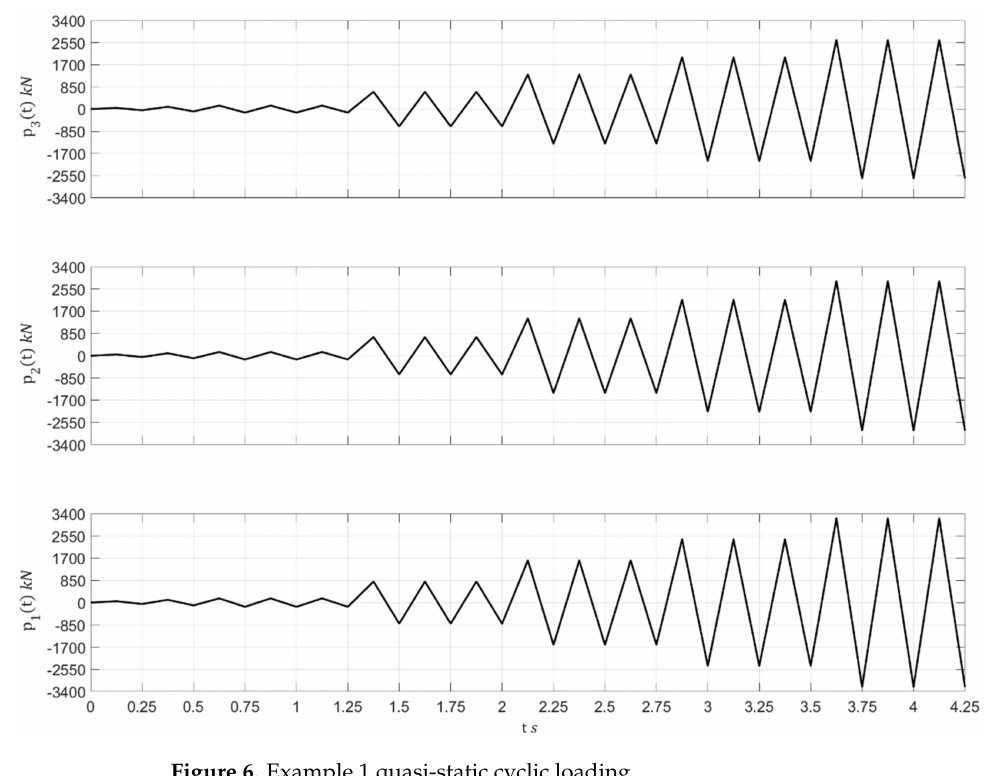
Figure 6. Example 1 quasi-static cyclic loading.